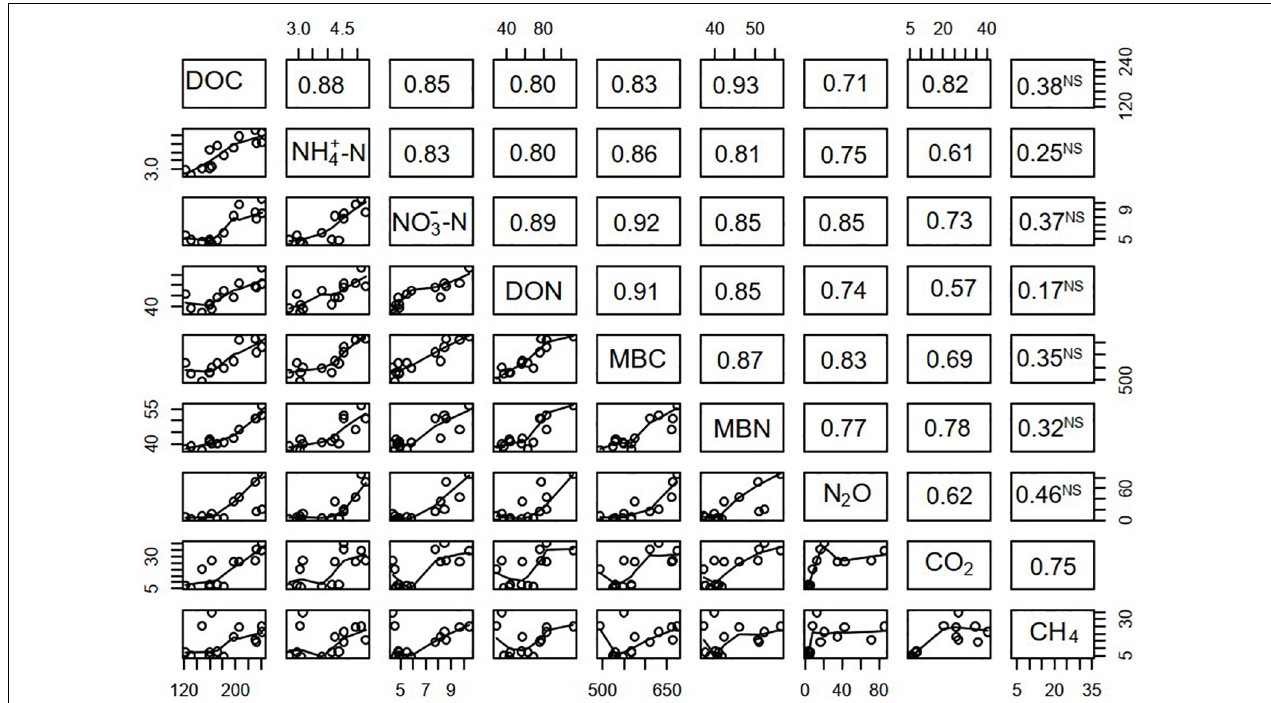
FIGURE 4 | Scatterplot matrix showing the Pearson correlation coefficients between the fluxes of N 2 O, CO 2 , and CH 4 and soil characteristics during FTCs. The upper right half of the matrix shows the correlation coefficients. The superscript “NS” next to the correlation coefficient indicates non-significance ( P ≥ 0.05); unmarked coefficients are significant ( P < 0.05). The lower left half shows the scatterplots and smooth curves.